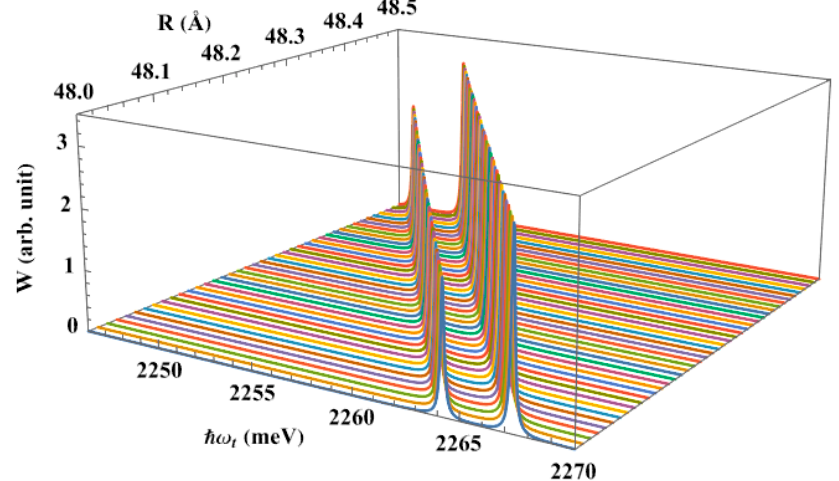
Figure 8. The interband absorption spectra, in the presence of the pump laser, as a function of the dot size, with θ 0 = 60 ◦ , (cid:125) ∆ ω = 0.3 meV, and A p = 30 × 10 6 .